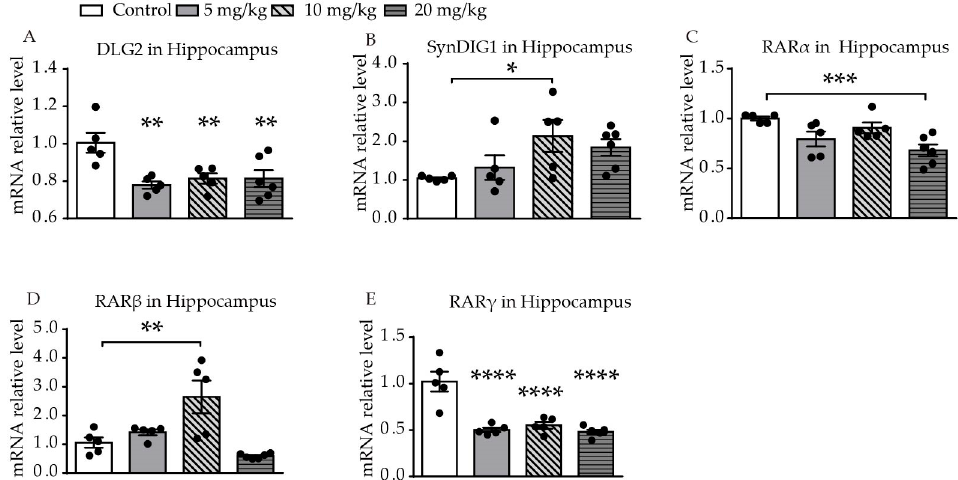
Figure 3. Effects of different doses of ATRA on mRNA expression levels of target genes in the hippocampus. Changes in mRNA expression levels of ( A ) DLG2 , ( B ) SynDIG1 , ( C ) RAR α , ( D ) RAR β , and ( E ) RAR γ in mice treated with 5 mg/kg, 10 mg/kg, and 20 mg/kg RA, compared with controls. Data are expressed as mean ± SEM, with n = 5–6 in each group. * p < 0.05, ** p < 0.01, *** p < 0.001, **** p < 0.0001 versus controls, using one way ANOVAs with LSD test.